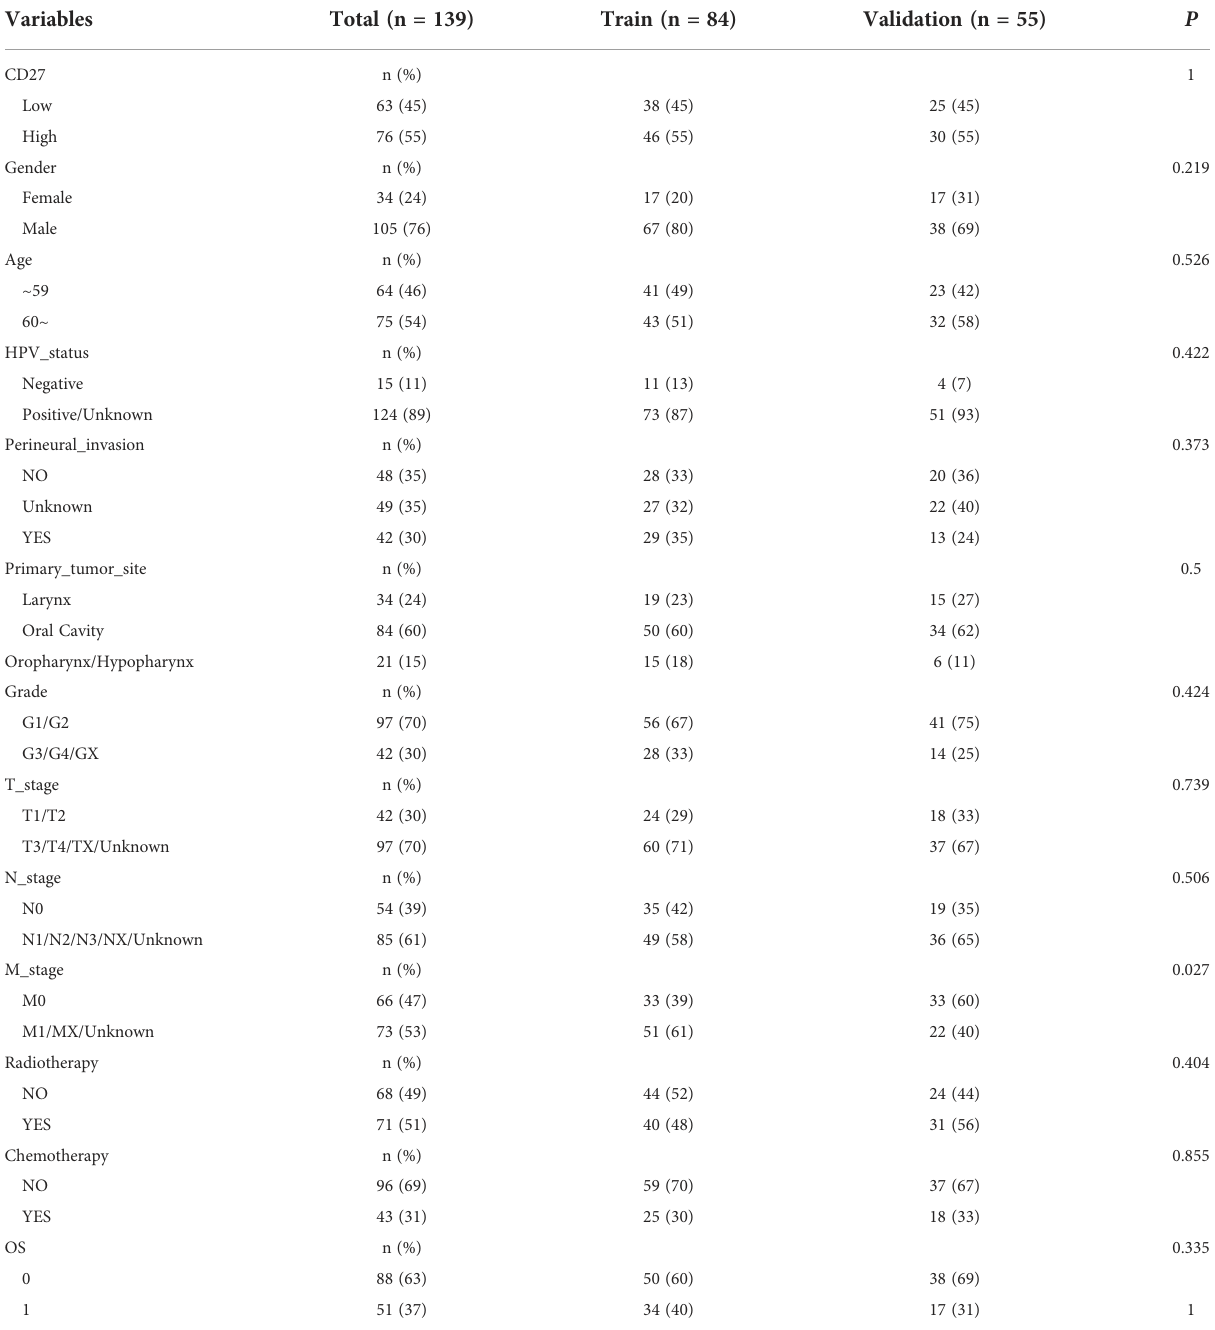
TABLE 2 Data set